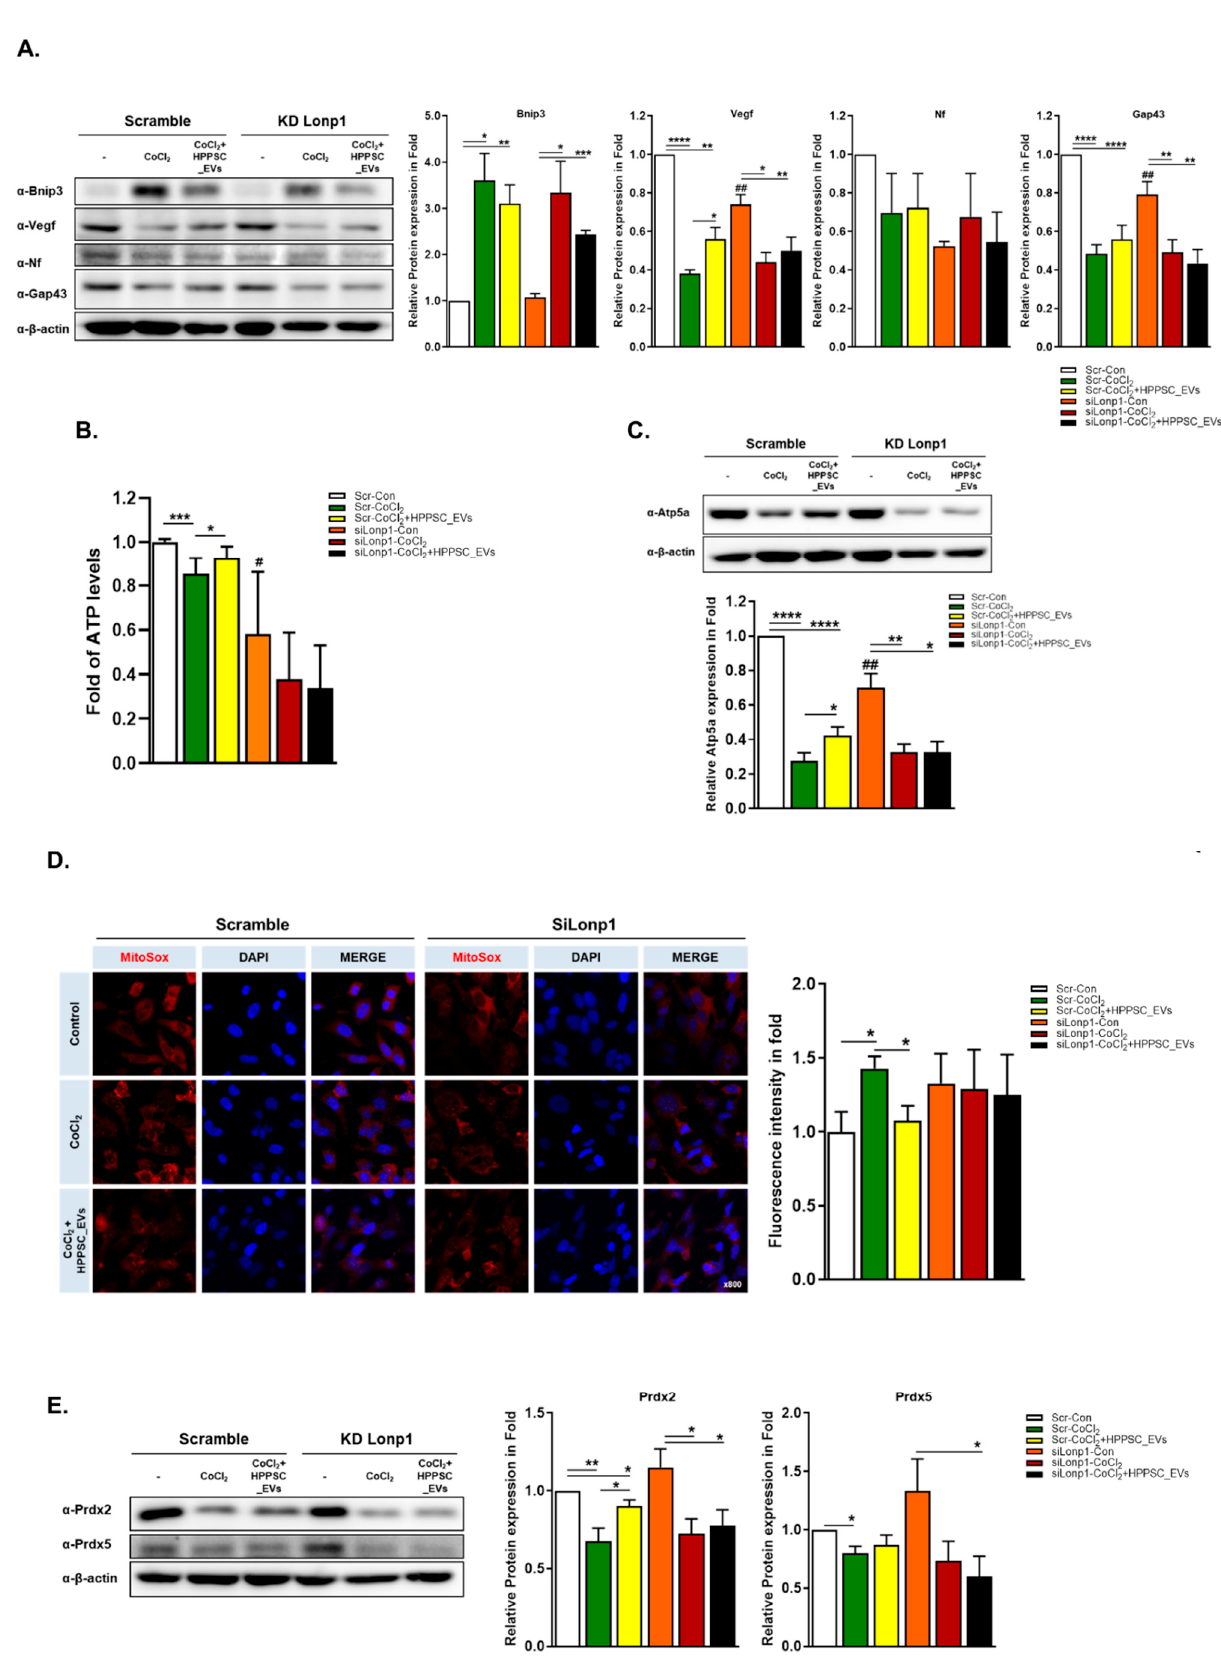
Figure 5. HPPSC_EVs regulate regeneration and mitochondrial function in the retinal precursor cells. Levels of regeneration ‐ related proteins were determined by immunoblot analyses of hypoxia ‐ damaged R28 cells. ( A ) Quantified values of Bnip3, Vegf, Neuroflament, NeuN, and Gap43